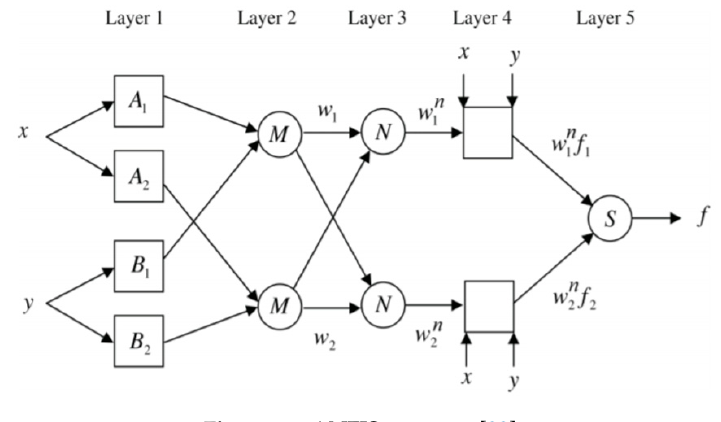
Figure 16. ANFIS structure [99].